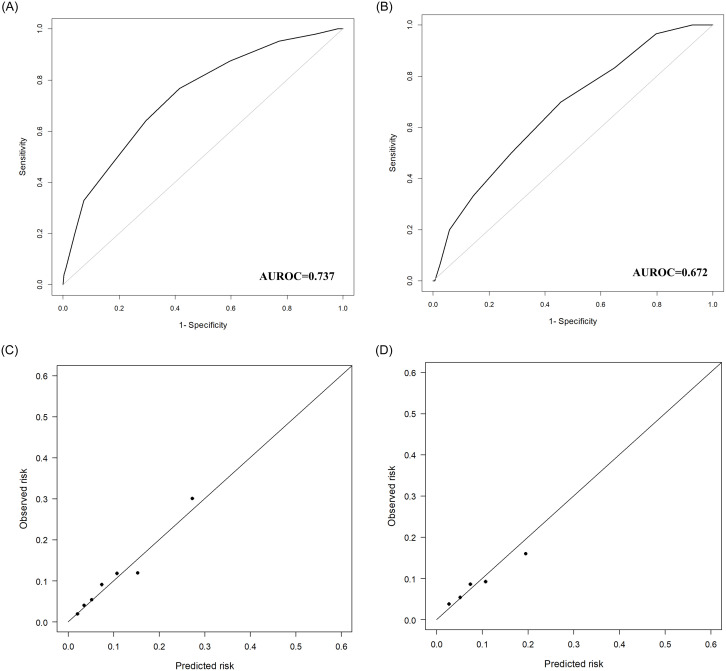
Receiver operating characteristic curves and calibration charts of the training and test cohorts.A. Receiver operating characteristic curve of the training cohort. B. Receiver operating characteristic curve of the test cohort. C. Calibration chart of the predicted versus observed risk of the training cohort. D. Calibration chart of the predicted versus observed risk of the test cohort.